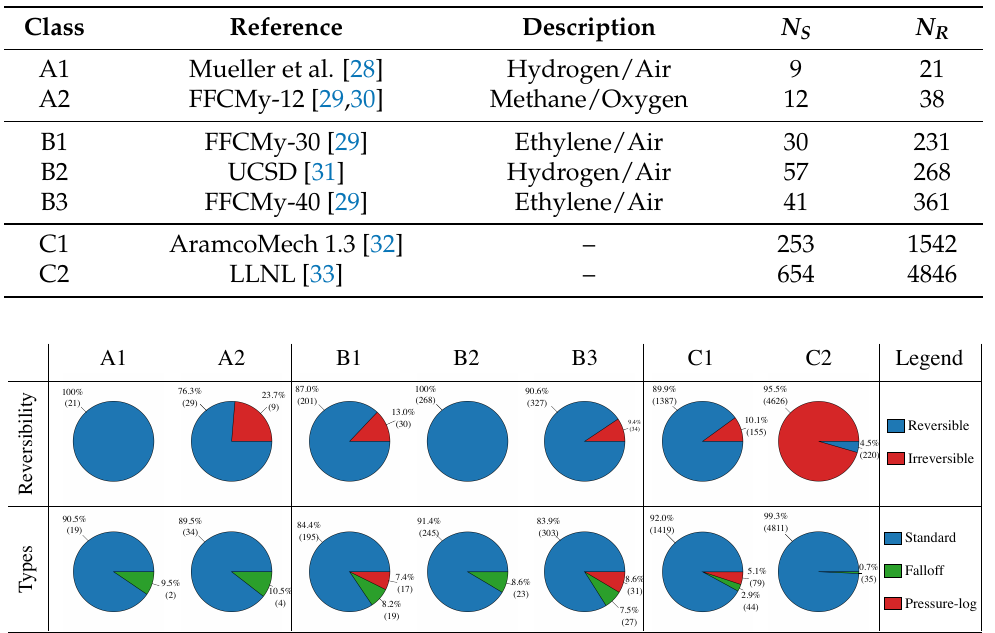
Figure 3. Reaction distributions shown as pie charts for the mechanisms listed in Table 1. The top row shows proportions of reversible and irreversible reactions, whereas the bottom row shows proportions of standard, falloff, and pressure-log reactions. Indicated for each wedge is the proportion (reaction number normalized by total number of reactions) as a percentage, and the absolute reaction number in parentheses. The significant difference in the reaction distribution for C2 with respect to reversibility is due to the fact that most of the reversible reactions were parameterized with Arrhenius expressions for both forward and reverse components (see the introductory comments of Section